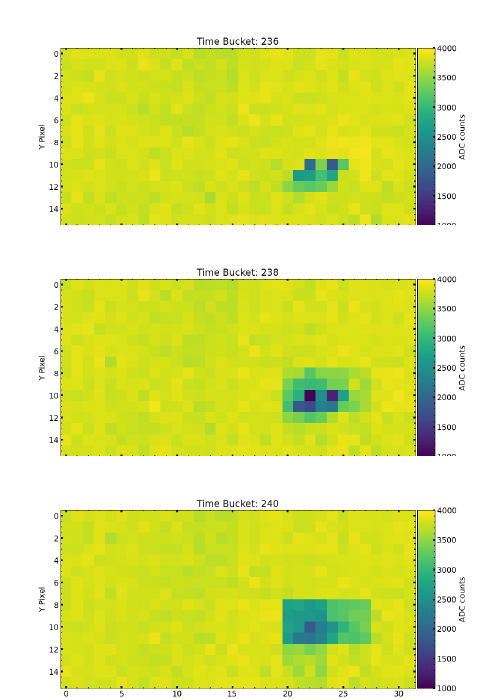
Figure 12: Progression of downward going cosmic ray as observed by the CT of EUSO-SPB2 during field tests. The three panels cover a 30 ns time window (Each time bucket is an integration of 10 ns), and clearly show the bifocal focusing of the